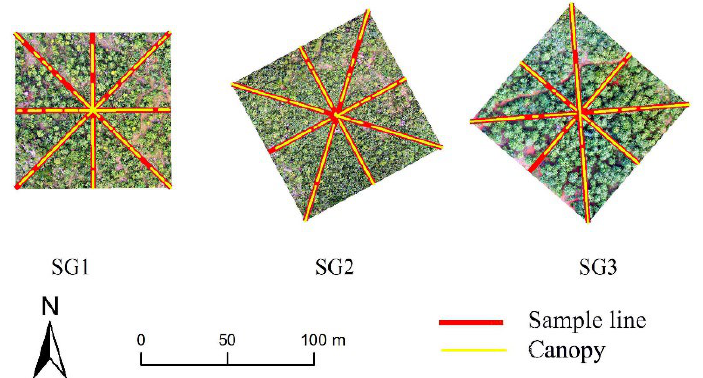
Figure 10. Results of the tiankeng-outside sample line measurement method. Table 7. An accuracy analysis of object-oriented method to extract sample plot canopy density.